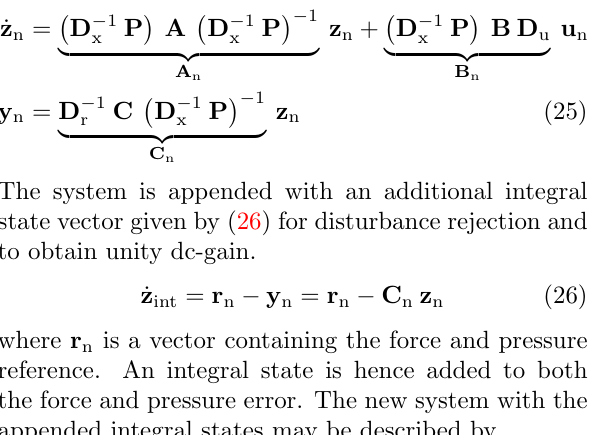
Fig. 11. Six cylinders connected to the common lines and with different load scenarios has been simulated to illustrate the performance in various cases. The pres- sure reference is shaped linearly to be in counter-phase with the force reference given by (42). It is chosen to only show the references and errors, since the responses would be identical to the references with the shown axis limits. It is seen that the maximum cylinder force error is ≈ ± 10 kN, which correspond to an error of ≈ 0 . 2 %. Tiny fluctuations are observed in the errors when the piston direction of motion is changed and the active valves are switched. The fluctuations are induced